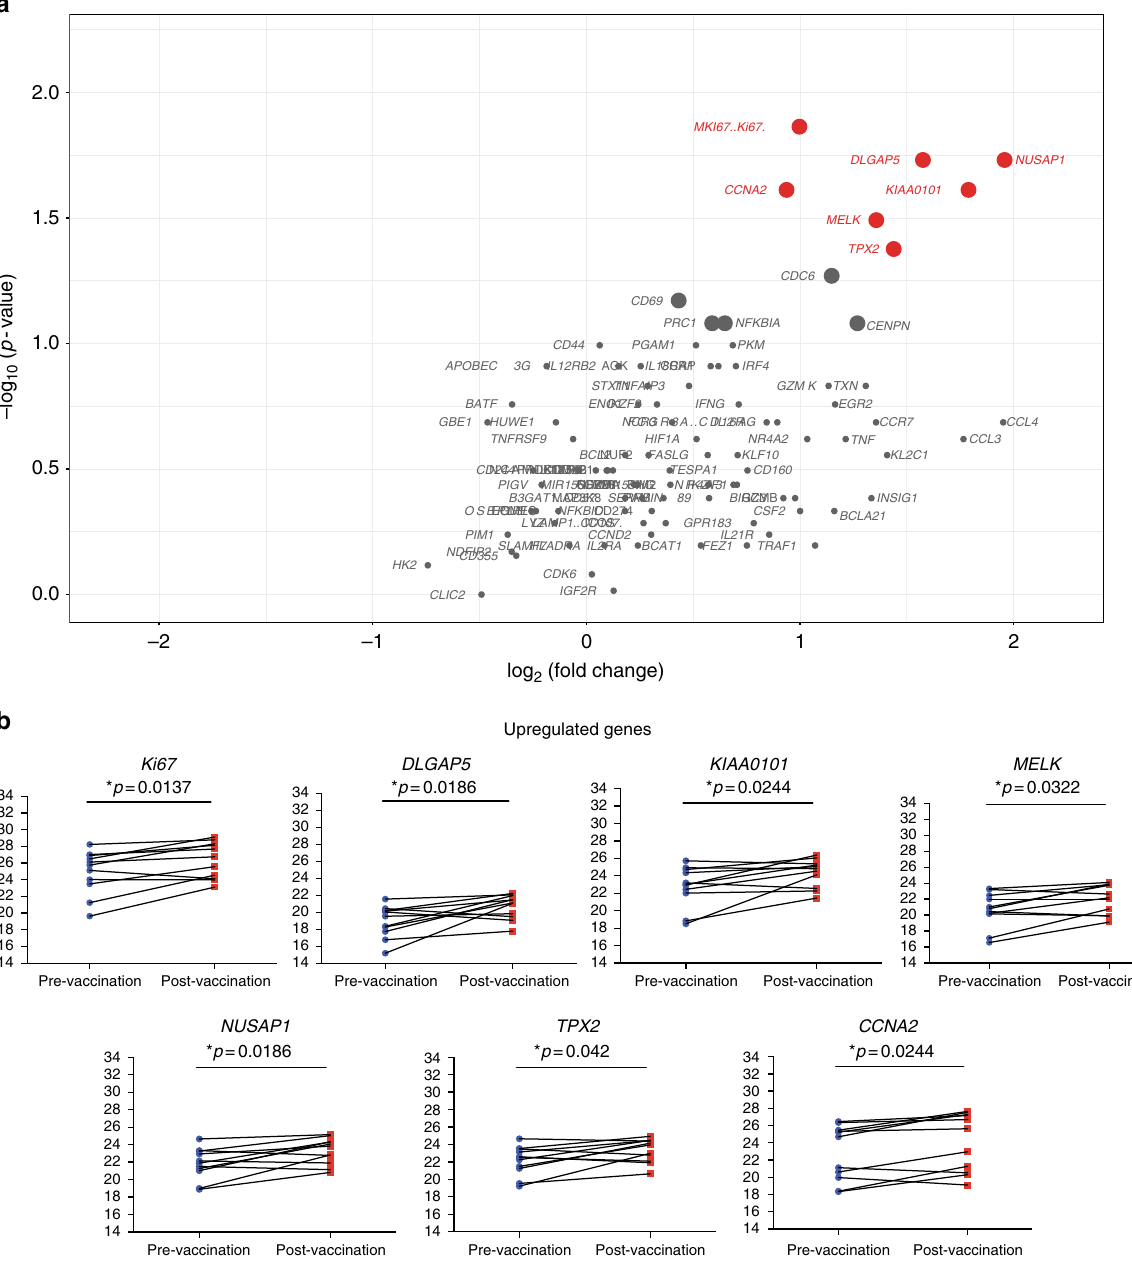
Fig. 6 Gene expression of activated NK cells in vaccinated individuals. a Volcano plots displaying upregulated (red) and stably expressed (gray) pre- selected genes, involved in NK cell-mediated responses to MVA vaccination. Size of each data point is calculated as − log 10 ( p -value) × log 2 (FC), p -value cutoff p < 0.05, fold change cutoff > 2 or <1/2. b Expression threshold (ET) values plotted for top upregulated genes between pre-vaccination group (blue) and post-vaccination group (red). ET values were calculated based on CT values (40-CT) obtained from the qPCR data. Transcriptional analysis from